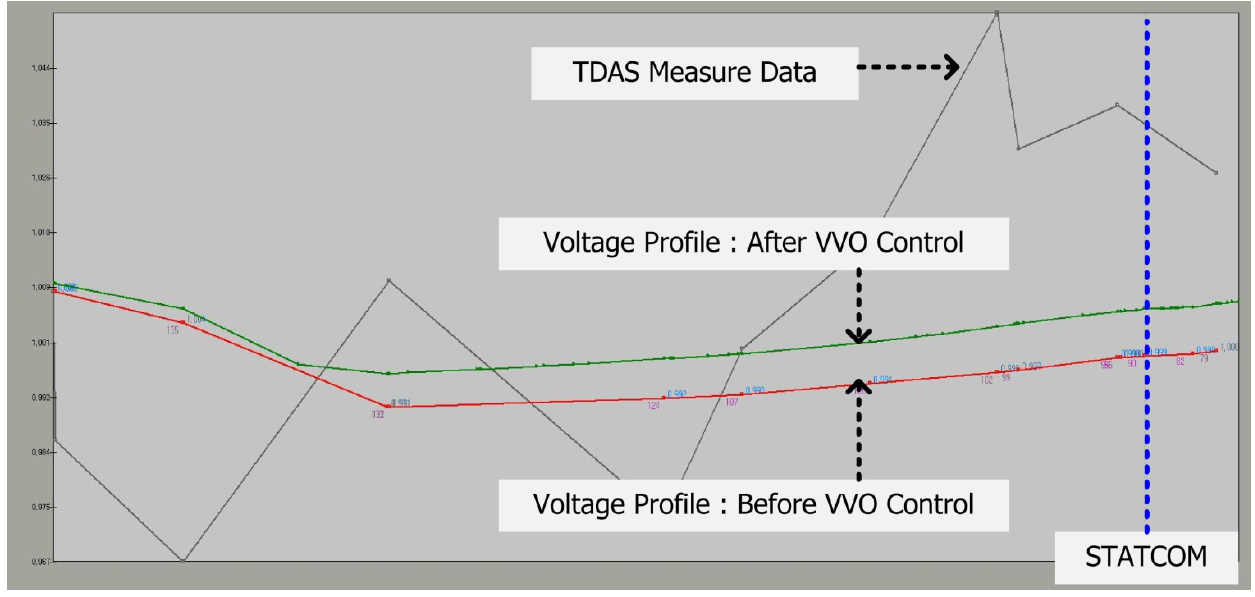
Figure 14. Test results of voltage control using the